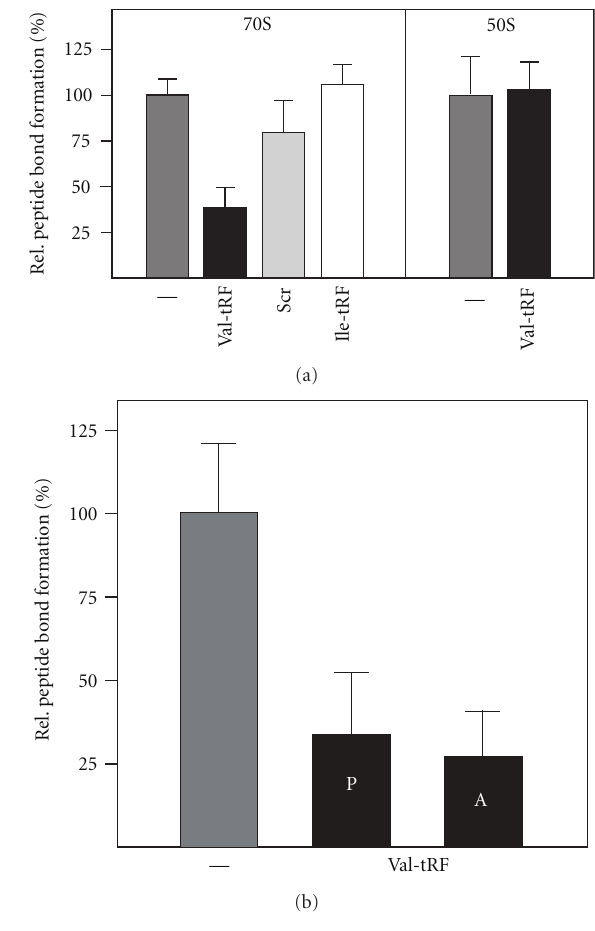
Figure 5: Val-tRF inhibits peptide bond formation. (a) Peptidyl transferase reactions catalyzed by H. volcanii 70S ribosomes (left panel) or 50S subunits (right panel) in the absence (-) or presence of 2.7 μ M Val-tRF (a 10-fold molar excess) were performed as described in Material and Methods. The scrambled version of the Val-tRF (scr) as well as Ile-tRF served as specificity controls. The relative amount of the reaction product N-acetyl-[ 3 H]Phe- puromycin (in %) is shown. The product formed in the absence of any tRF (-) was taken as 100%. (b) Val-tRF inhibits peptide bond formation to the same extent regardless if it was added simultaneously with the P-site donor substrate (P) or with the A-site acceptor substrate (A). In all cases, the background values measured in reactions without any ribosomal particles were subtracted from all experimental points. Error bars represent the mean and standard deviation of three to five independent